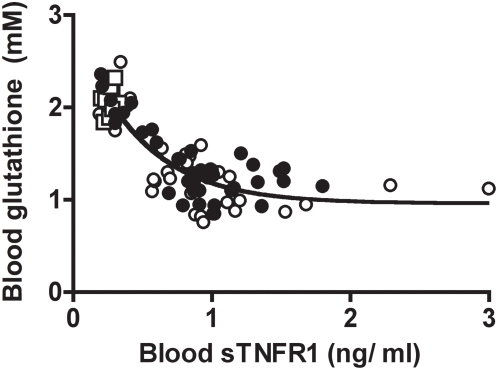
Correlation between blood glutathione and blood sTNFR1 levels in cardiac patients and healthy controls.Blood glutathione level decrease was exponentially correlated with elevation in blood sTNFR1 level in the whole cohort of patients (r = 0.88). Open squares: controls; open circles: younger patients ≤65 years (mean age = 55±1 years; r = 0.88); closed circles: older patients >65 years (mean age = 74±1 years; r = 0.87).